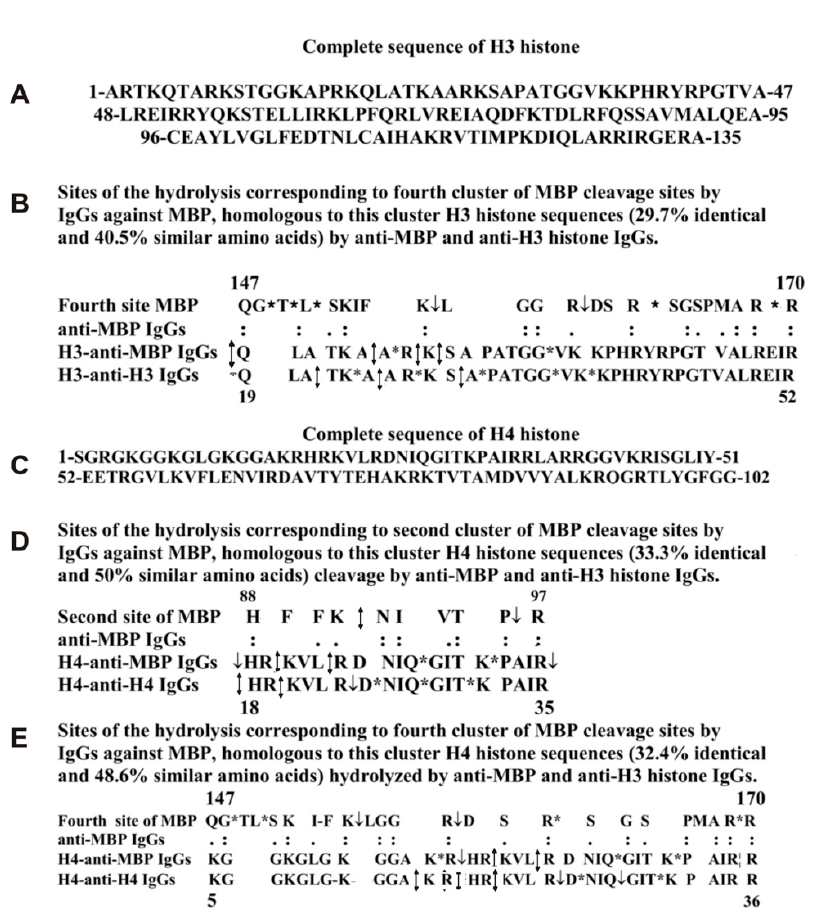
Figure 8. The complete sequence of H3 histone ( A ). Analysis of homology between sequence of the fourth cleavage sites of MBP corresponding to anti-MBP IgGs with one sequence of H3 histone, which are homologous to this MBP cluster and hydrolyzed by both anti-MBP and anti-H3 histone IgGs ( B ). A complete sequence of H4 histone ( C ). Analysis of homology between sequence of the second ( D ) and fourth ( E ) cleavage sites of MBP corresponding to anti-MBP IgGs with two sequences of H4 histone, which are homologous to these MBP clusters and hydrolyzed by both anti-MBP and anti-H4 histone IgGs. Major sites of the cleavage are marked by double arrows ( ↕ ), moderate ones by arrows ( ↓ ), and minor sites of the hydrolysis by stars (*) ( A – C ).